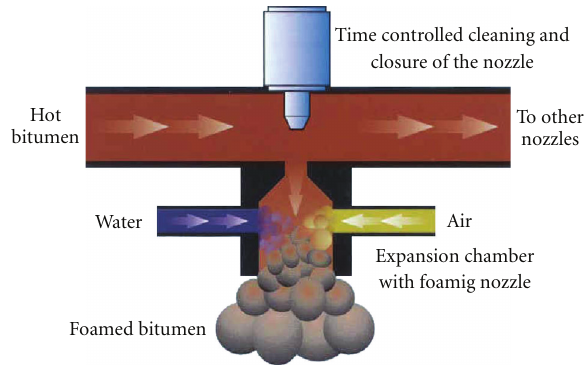
Figure 1: Foamed asphalt production